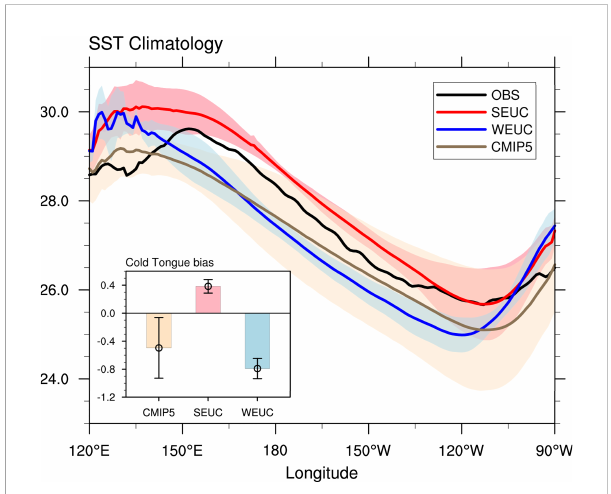
FIGURE 10 JFM mean SST (units: °C) averaged over the equatorial Paci fi c (2° S – 2° N) from the observations (black curve), the MME of the CMIP5 models (brown curve), the composite of the SEUC group (red curve) and the WEUC group (blue curve). Light brown, red, and blue shading indicate the standard deviations among the models, respectively. The histograms at the lower left represent the cold tongue bias averaged over the region (2° S – 2° N, 175° E – 90° W) in the MME of the CMIP5 models (light brown bar), the composite of the SEUC group (red bar), and the WEUC group (blue bar). The error bars indicate the standard deviation spread among the corresponding